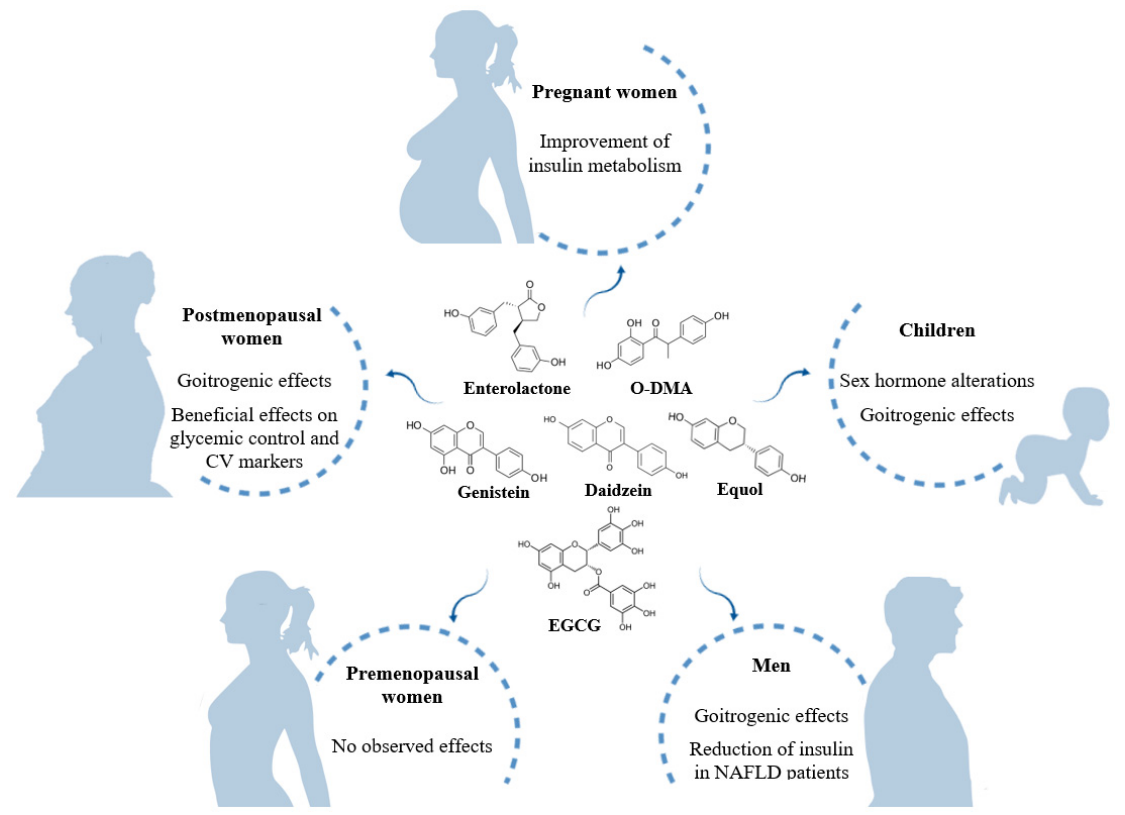
Figure 3. Summary of the effects of dietary phytoestrogens at different life stages. NAFLD: non-alcoholic fatty liver disease.